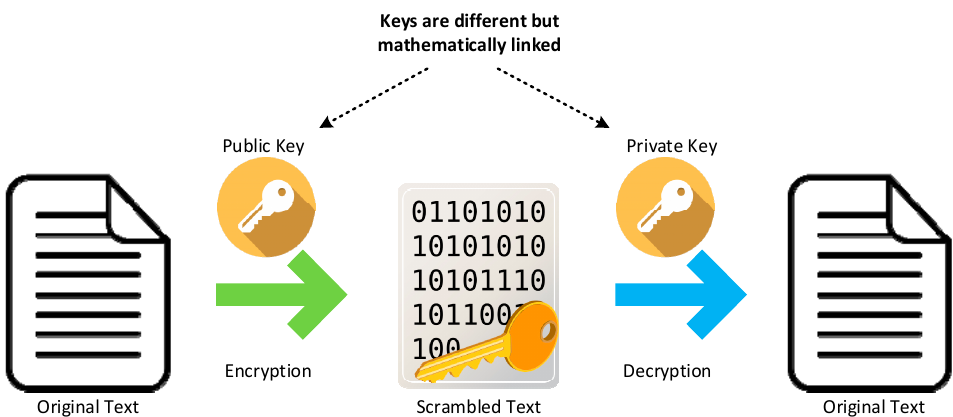
Figure 5. Asymmetric key encryption for the data encryption and decryption.